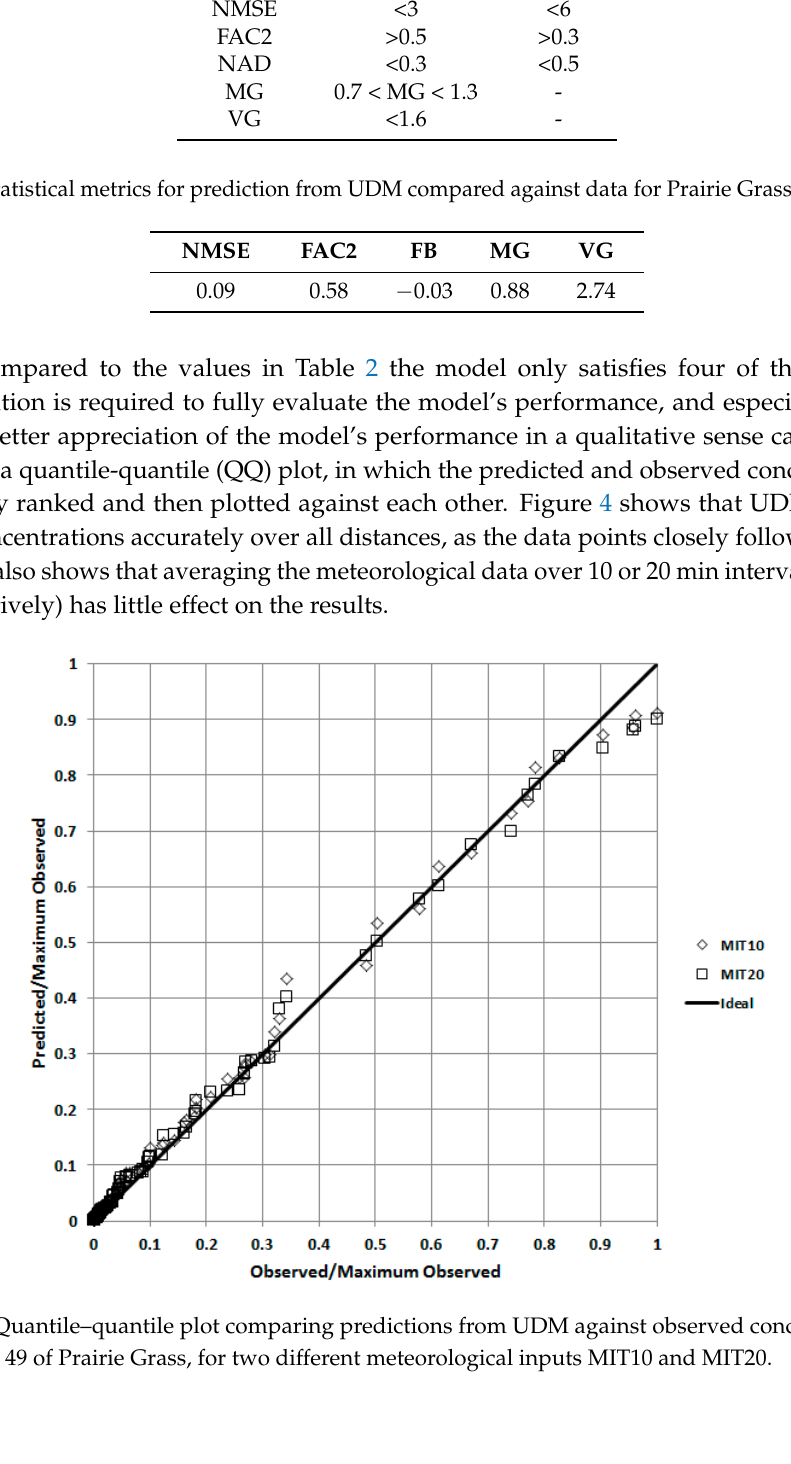
Table 2. The bounds of acceptable performance for dispersion models as proposed by Hanna et al. [21], Hanna and Chang [22] and Chang and Hanna [23].